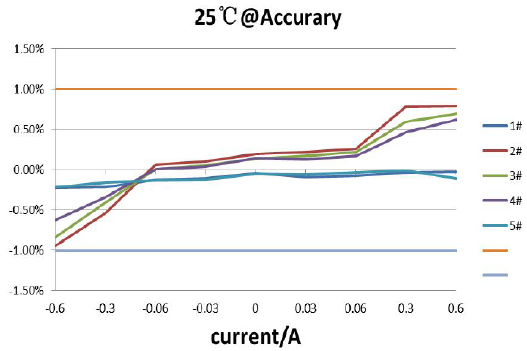
Figure 18. The diagram of accuracy curve.